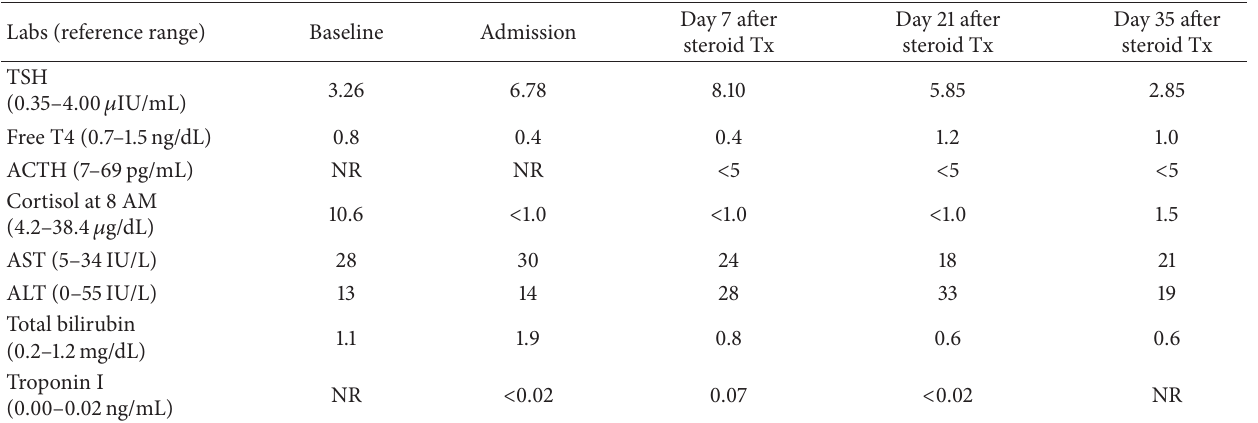
Table 1: Lab values during the hospitalization, baseline TSH, free T4, and cortisol levels were within normal range; however, patient presented with elevated TSH, low free T4, and decreased cortisol levels, suggesting immune-mediated hypothyroidism and adrenal